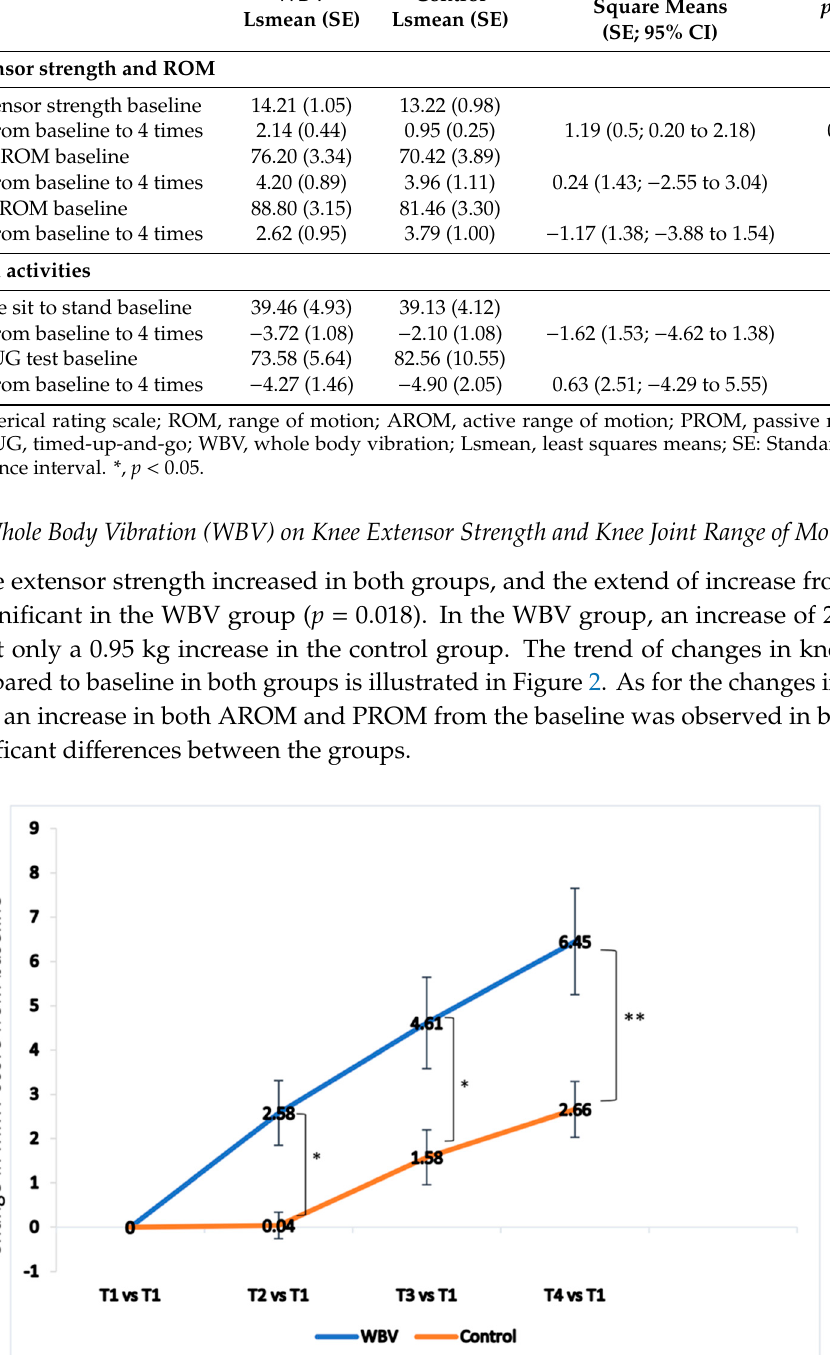
post-operative day 2; T2, post-intervention assessment on post-operative day 2; T3, pre-intervention assessment on post-operative day 3; T4, post-intervention assessment on post-operative day 3 (T4). * p < 0.05, ** p <